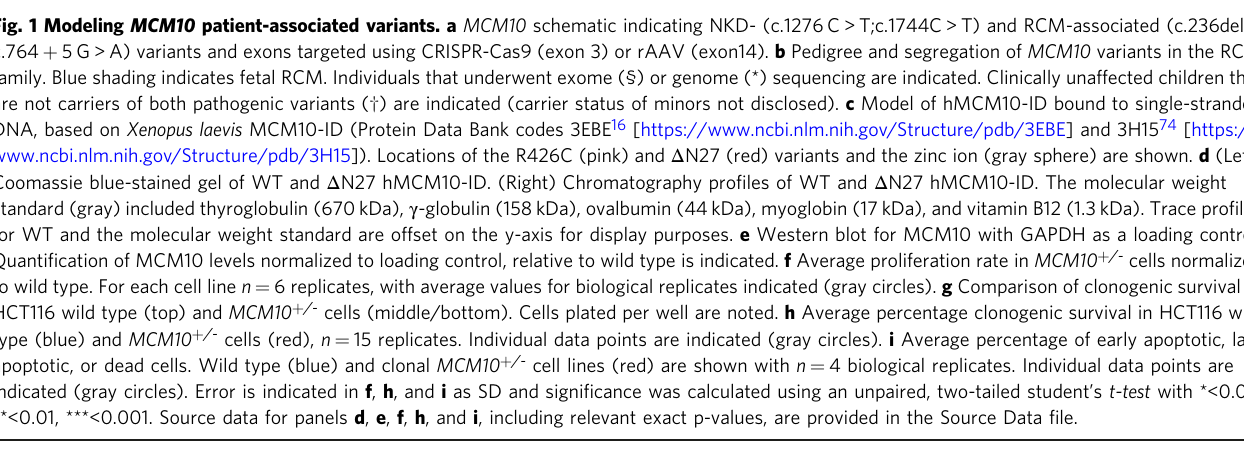
Fig. 1 Modeling MCM10 patient-associated variants. a MCM10 schematic indicating NKD- (c.1276C > T;c.1744C > T) and RCM-associated (c.236delG; c.764 + 5 G > A) variants and exons targeted using CRISPR-Cas9 (exon 3) or rAAV (exon14). b Pedigree and segregation of MCM10 variants in the RCM family. Blue shading indicates fetal RCM. Individuals that underwent exome (§) or genome (*) sequencing are indicated. Clinically unaffected children that are not carriers of both pathogenic variants ( † ) are indicated (carrier status of minors not disclosed). c Model of hMCM10-ID bound to single-stranded DNA, based on Xenopus laevis MCM10-ID (Protein Data Bank codes 3EBE 16 [https://www.ncbi.nlm.nih.gov/Structure/pdb/3EBE] and 3H15 74